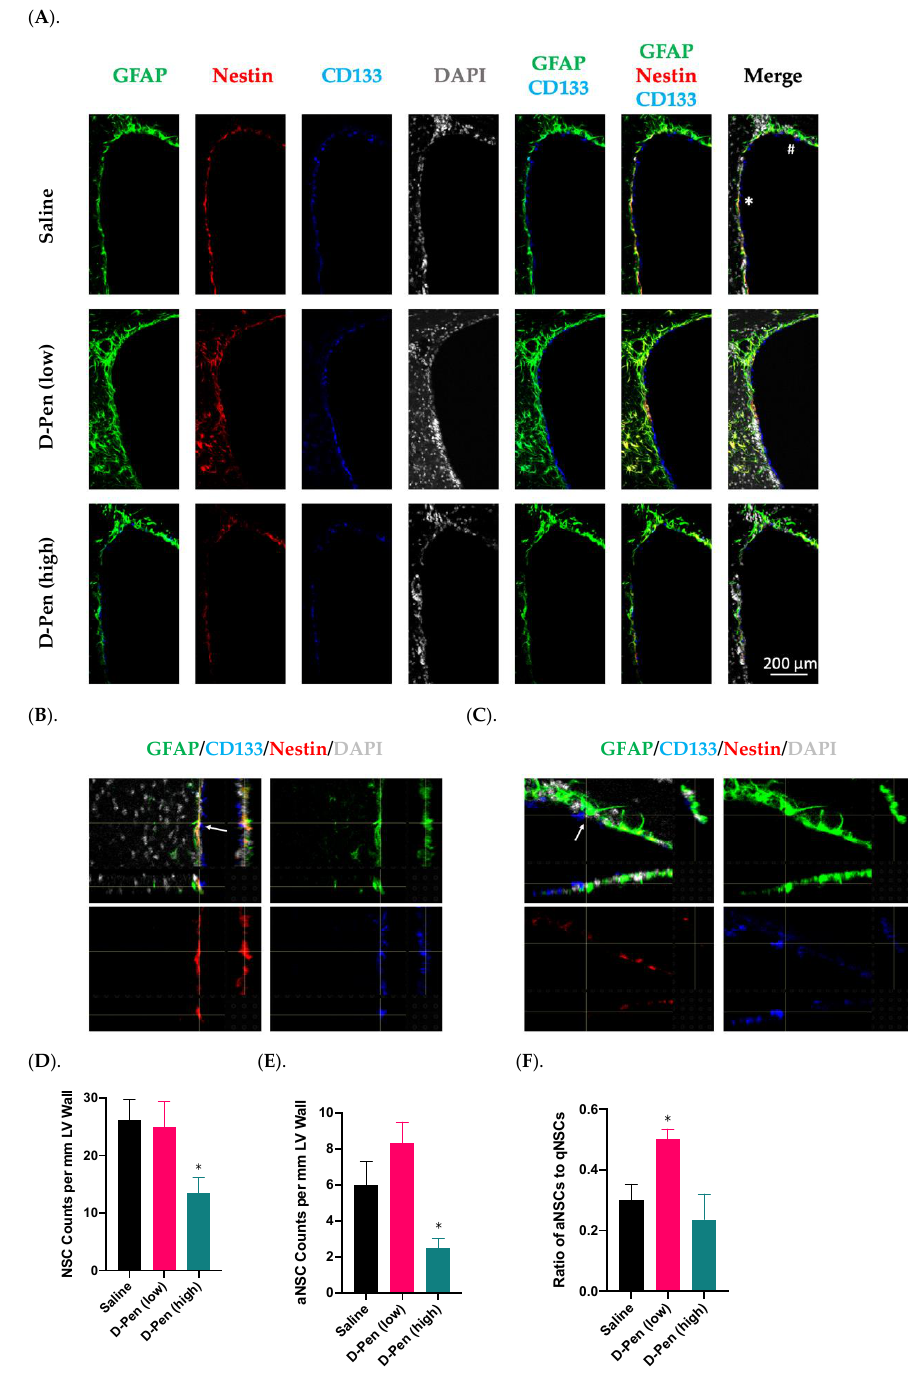
Figure 8. Adult NPSC pools in SVZ following long-term ICV D-Pen infusion. ( A ). Adult NSPC pool and cell identities revealed by staining with GFAP, CD133, and Nestin. Scale bar = 200 µm. ( B ). The asterisk-marked SVZ of a saline-infused mouse showing an aNSC: GFAP(+)-CD133(+)-Nestin(+). An arrow was used to show signal overlapping within this cell. ( C ). The pound-marked SVZ of a saline-infused mouse showing a representative qNSC: GFAP(+)-CD133(+)-Nestin(-). An arrow was used to show signal overlapping within this cell. ( D ). Quantification of GFAP(+)-CD133(+) NSCs in the anterior SVZ. ( E ). Quantification of GFAP(+)-CD133(+)-Nestin(+) aNSCs in the anterior SVZ. ( F ). Ratio of aNSCs to qNSCs in the anterior SVZ. For panels ( D – F ), data represent mean ± SD, n = 3/group. * p < 0.05, as compared with the saline-infused